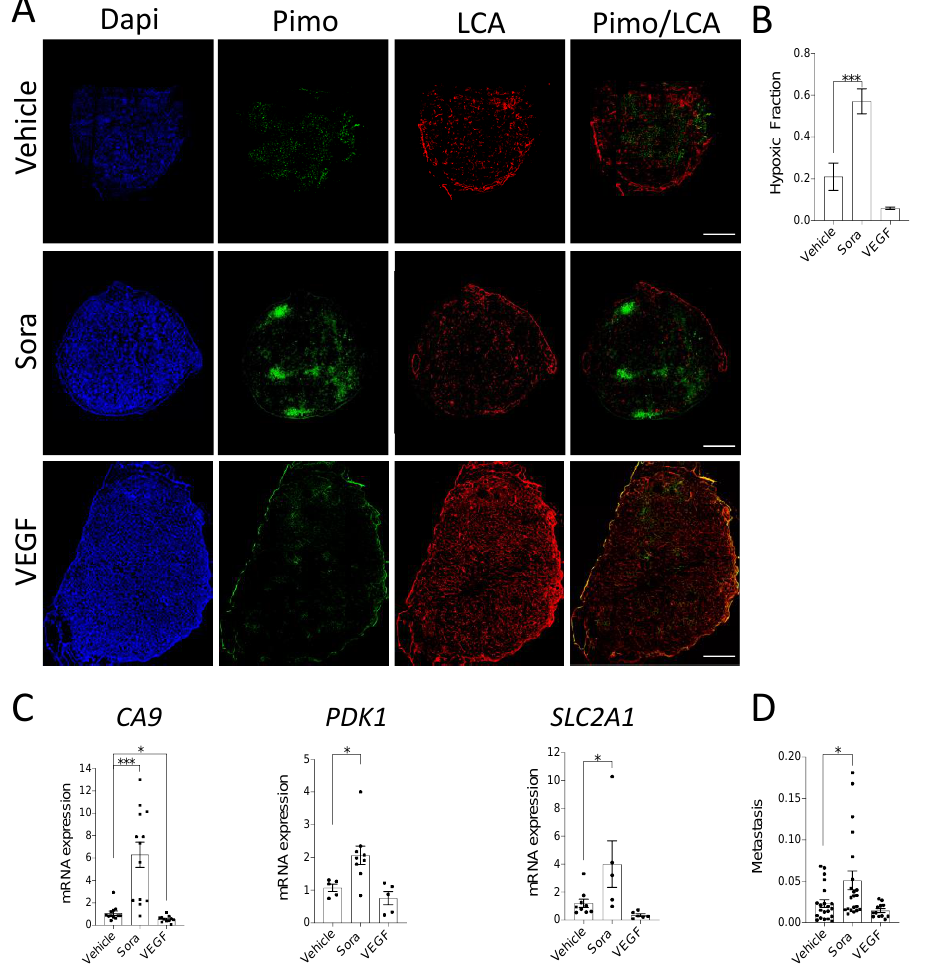
Figure 3. ( A – C ) HT-1080 cell suspensions were inoculated onto the CAM in the presence or absence of VEGF while Sorafenib (Sora) or DMSO (Vehicle) were added topically to the developing tumors every day. A mix of LCA and pimonidazole was injected into CAM vasculature prior to tumor extraction from the CAM. ( A ) Representative immunofluorescence images showing regions of hypoxia (pimonidazole; green) and vascularization (LCA; red) in control and treated tumor xenografts are shown. Nuclei were stained with DAPI (blue). Scale bar = 500 µm ( B ) The hypoxic fraction of control or treated tumor xenografts was quantified ( n = 5 – 7). ( C ) Relative mRNA expression of CA9 , SLC2A1 (GLUT1), and PDK1 in treated vs control tumor xenografts is shown ( n = 5 – 13). ( D ) Embryonic livers were harvested after 7 days of tumor growth for genomic DNA extraction. The ability of HT1080 cells to disseminate in embryonic livers was quantified as the relative amount of metastasis (Alu) normalized to the amount of host DNA (GAPDH). Metastasis per mm 3 of original tumor is shown ( n = 12 – 21). Bars represent the mean ± SEM. The asterisks (*) correspond to p < 0.05 (*) and p < 0.001 (***), one-way ANOVA.